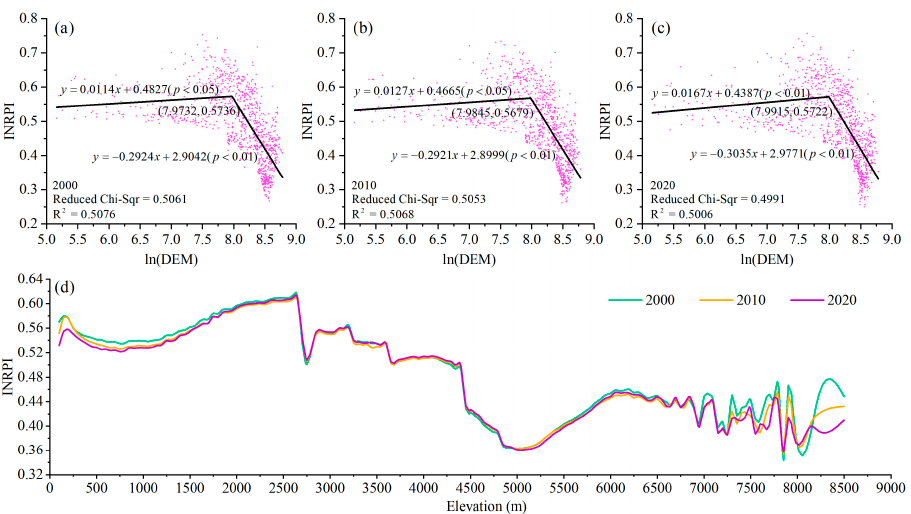
Figure 7. The relationship between elevation and INRPI from 2000 to 2020. ( a – c ) Correlations between DEM and INRPI in 2000, 2010, and 2020, respectively. ( d ) Distribution of INRPI in different elevation in 2000, 2010, and 2020, respectively.